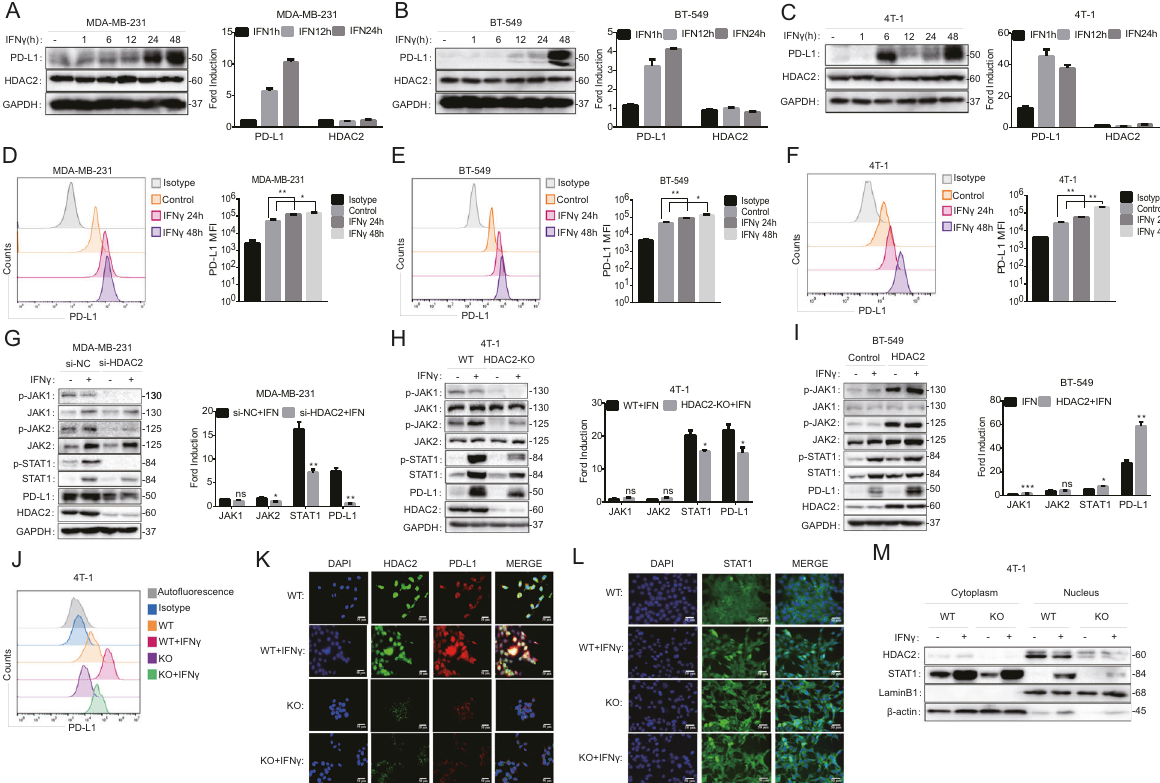
Fig. 3 HDAC2 promoted the IFN γ -induced PD-L1 expression in TNBC cells via activation of the JAK – STAT1 pathway. A – C MDA-MB-231 ( A ), BT-549 ( B ), and 4T-1 ( C ) cells were cultured with IFN γ (100U/ml) for 1, 6, 12, 24, and 48 h. The expression of HDAC2 and PD-L1 was tested by western blotting and RT-PCR ( n = 3). D – F MDA-MB-231 ( D ), BT-549 ( E ), and 4T-1 ( F ) cells were cultured with IFN γ (100 U/ml) for 24 and 48 h. The expression of PD-L1 was tested by fl ow cytometry ( n = 3). G MDA-MB-231 cells were transfected with si-RNA for 24 h, and then cultured with or without IFN γ (100 U/ml) for 24 h. The expression of PD-L1 and HDAC2 was examined by western blotting and RT-PCR ( n = 3), including the proteins involved in IFN γ pathway. H Similar to G, but 4T-1 (WT, HDAC2-KO) cells were stimulated by IFN γ (100 U/ml) for 24 h. I Similar to G , but BT-549 cells were transfected with HDAC2 expression plasmids for 24 h before IFN γ (100 U/ml) treatment. J PD-L1 expression was determined in 4T-1 (WT, HDAC2-KO) by fl ow cytometry after culturing with or without IFN γ (100 U/ml) for 24 h ( n = 3). K The expression of PD- L1 and HDAC2 was examined by immuno fl uorescence staining in 4T-1 cells (WT, HDAC2-KO) cells after stimulation with or without IFN γ (100 U/ml) for 24 h, original magni fi cation: 100×. Scale bars, 50 μ m; n = 3 independent experiments were performed with similar results. L Similar to K , 4T-1 cells (WT and HDAC2-KO) were treated by IFN γ (100 U/ml) for 30 min. The expression of STAT1 was determined by immuno fl uorescent staining assays. M Western blotting results showed the cytoplasmic and nuclear expression of HDAC2 and STAT1 in 4T-1 cells (WT, HDAC2-KO) after culturing with or without IFN γ (100 U/ml) for 12 h.